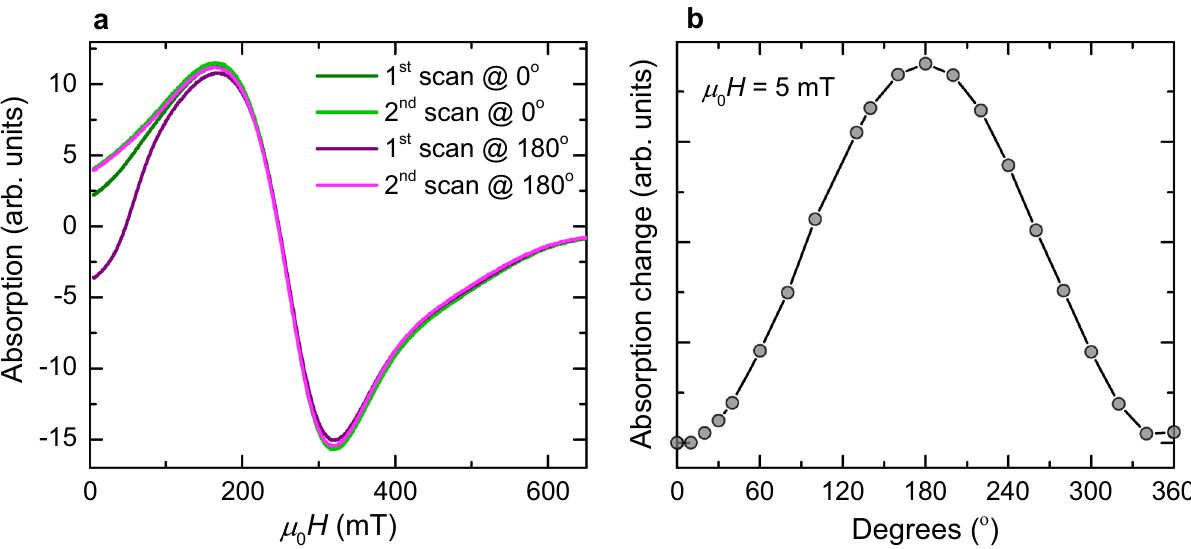
Figure 4. Rotational behaviour of FMR spectra at 300 K. ( a ) Initial and second spectra in 0° positions and first and second spectra in 180° positions with varying absorption behaviours in the low-field range at μ 0 H < 200 mT and with second scans superimposed. ( b ) Angular effect of the absorption in μ 0 H = 5 mT depicted as the departure from the reference absorption [2nd scans shown in ( a )] in absolute